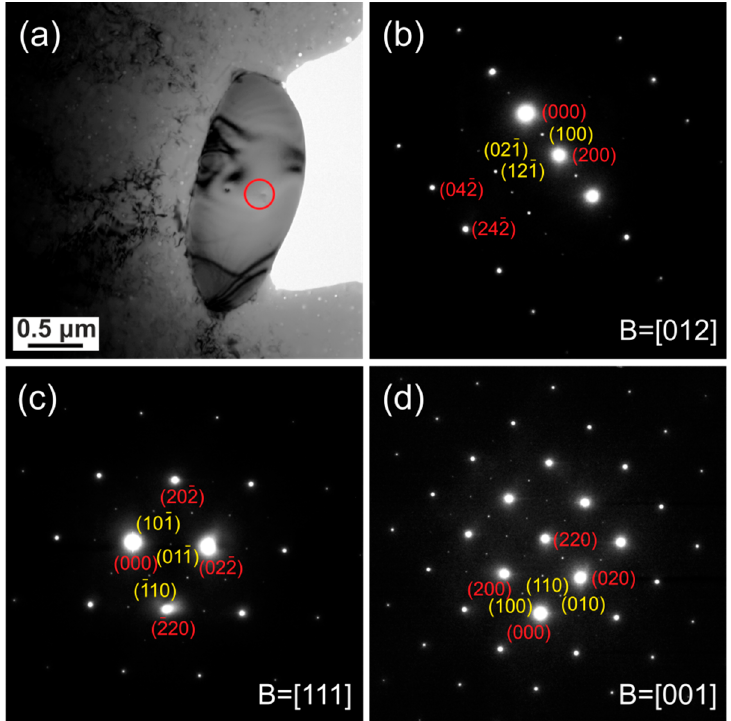
Figure 6. ( a ) Bright field TEM image of a typical primary carbonitride in the long-term aged Super304H steel. ( b–d ) are selected area electron diffraction (SAED) patterns of the carbonitrides taken along [012], [111] and [001] zone axis, respectively.